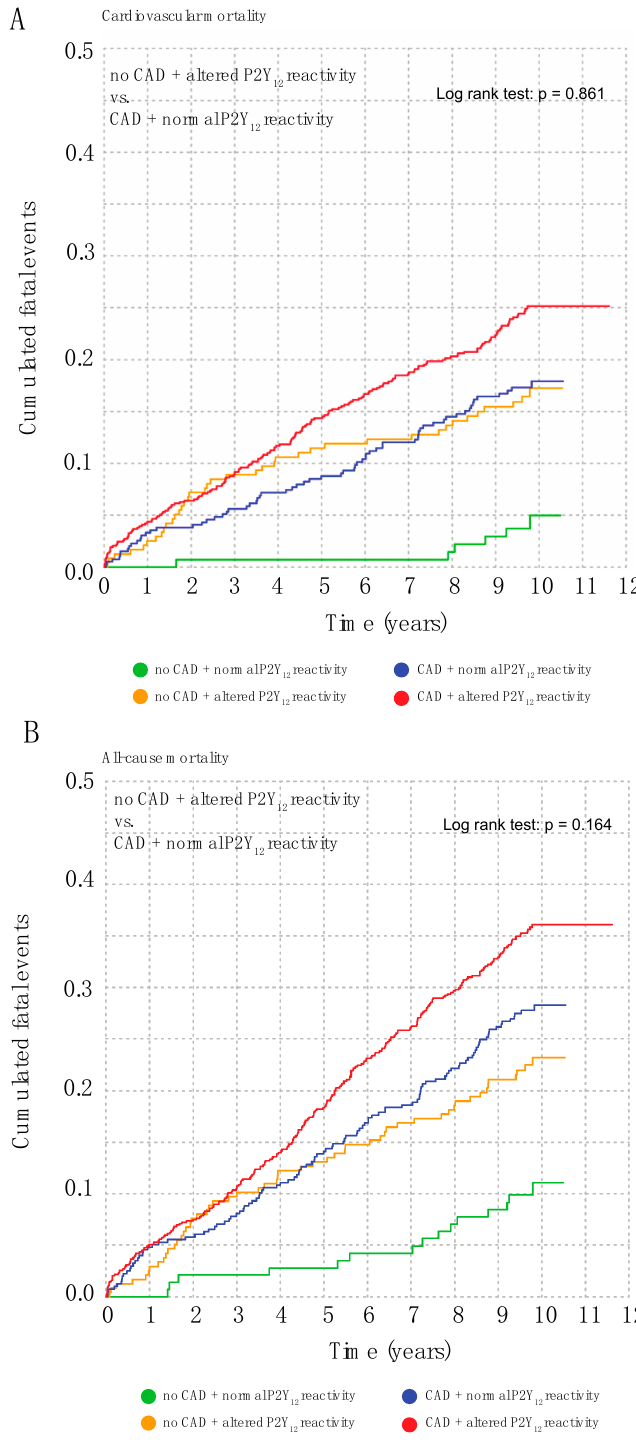
Figure 2. High- and Low-platelet reactivity is risk-equivalent to coronary artery disease. Kaplan- Meier cumulative event curves in 1520 patients for cardiovascular ( A ) and all-cause mortality ( B ) in patients stratified by the presence (i.e., at least ≥ 1 angiographically verified stenosis of ≥ 20%) and absence of coronary artery disease and High/Low platelet reactivity.